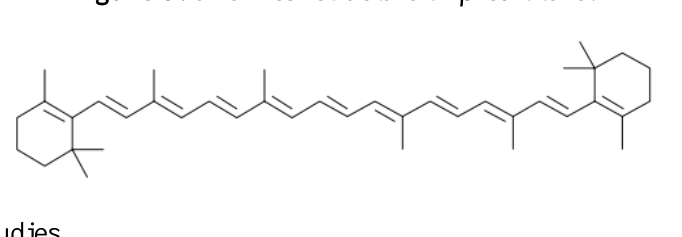
Figure 3. Chemical structure of β